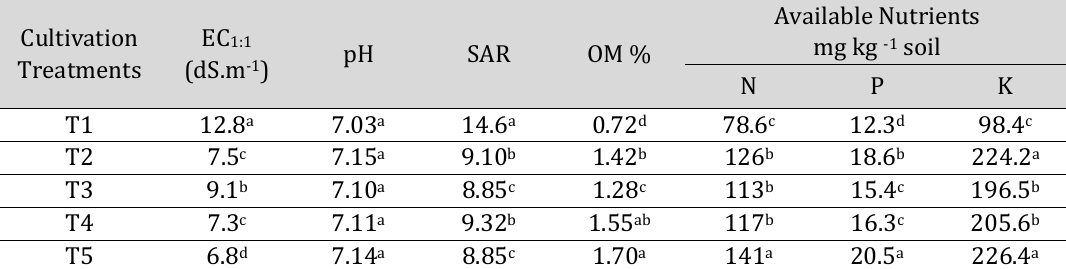
Table 3. Some chemical p ropert ies of the soil su rfac e layer (0 - 30 cm) a ft er p lant ing an d incorpor ating plant residues in su cces sion f or se asons fro m 2013 to 20 15